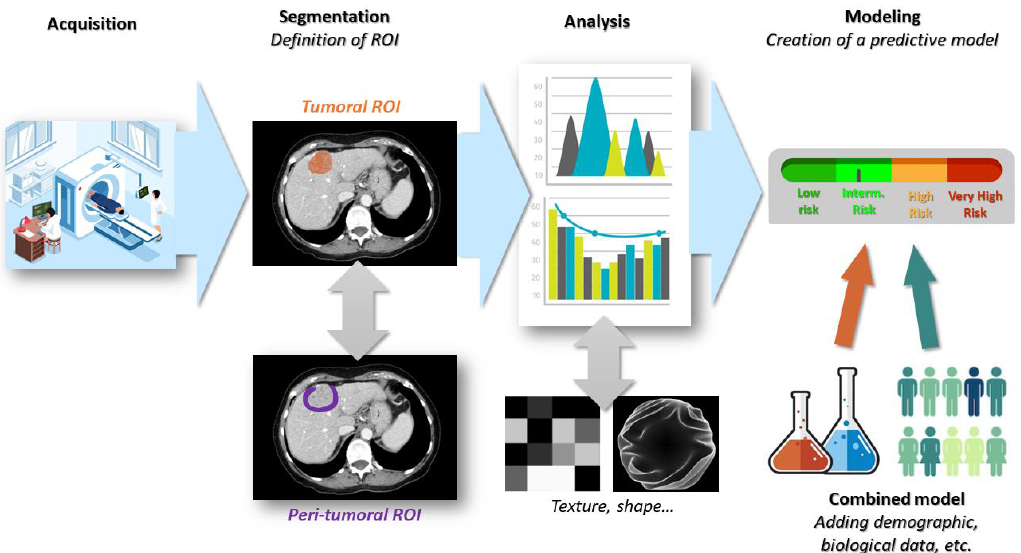
Figure 2. Example of two second-order radiomics features, Gray-Level Run-Length Matrix (GLRLM) and Gray-Level Co-occurrence Matrix (GLCM).